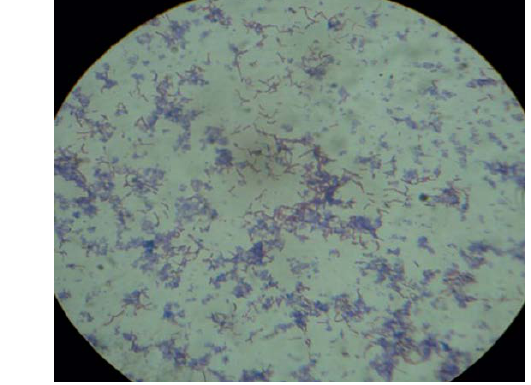
Fig. 2. Gram straining of Rhodococcus sp . LKE-021